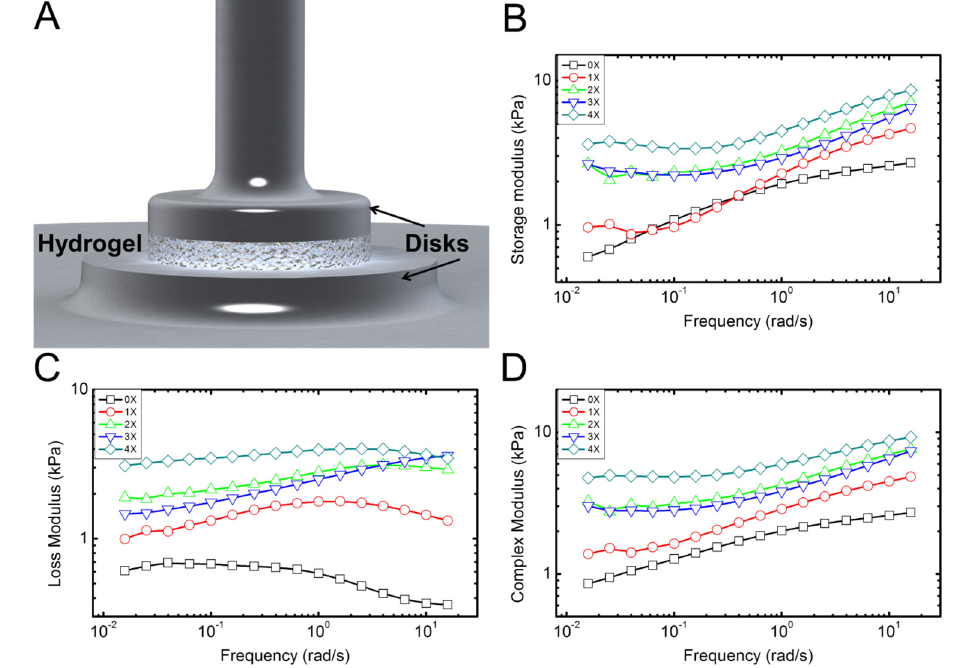
Figure 4. Characterization of the rheological properties of the hydrogel samples. ( A ) Schematic shows the disk-shaped hydrogel sample between the two circular disks of the rheometer; ( B – D ) Typical plots of the storage, loss, and complex moduli, respectively, extracted from the rheological measurements. Five samples for each concentration were